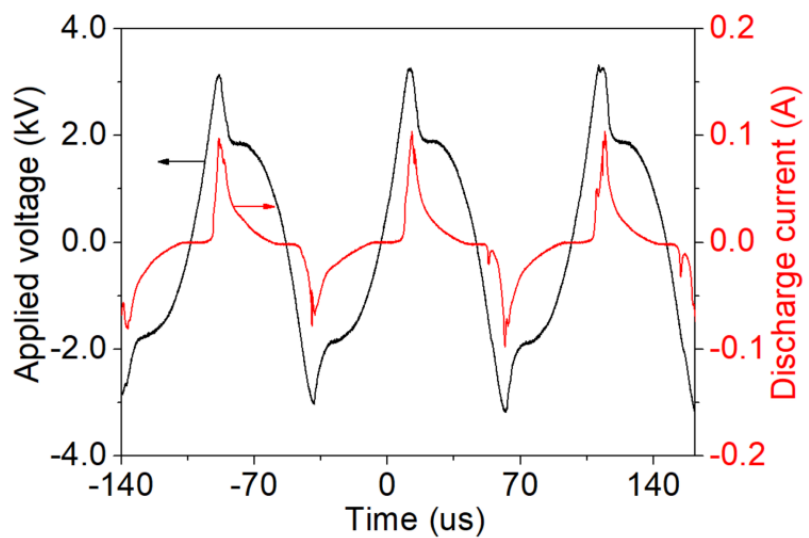
Figure 2. Waveforms of applied voltage and discharge current. (Ar flow rate: 2.1 L/min, discharge gap: 2 mm, applied voltage: 6.2 kV).